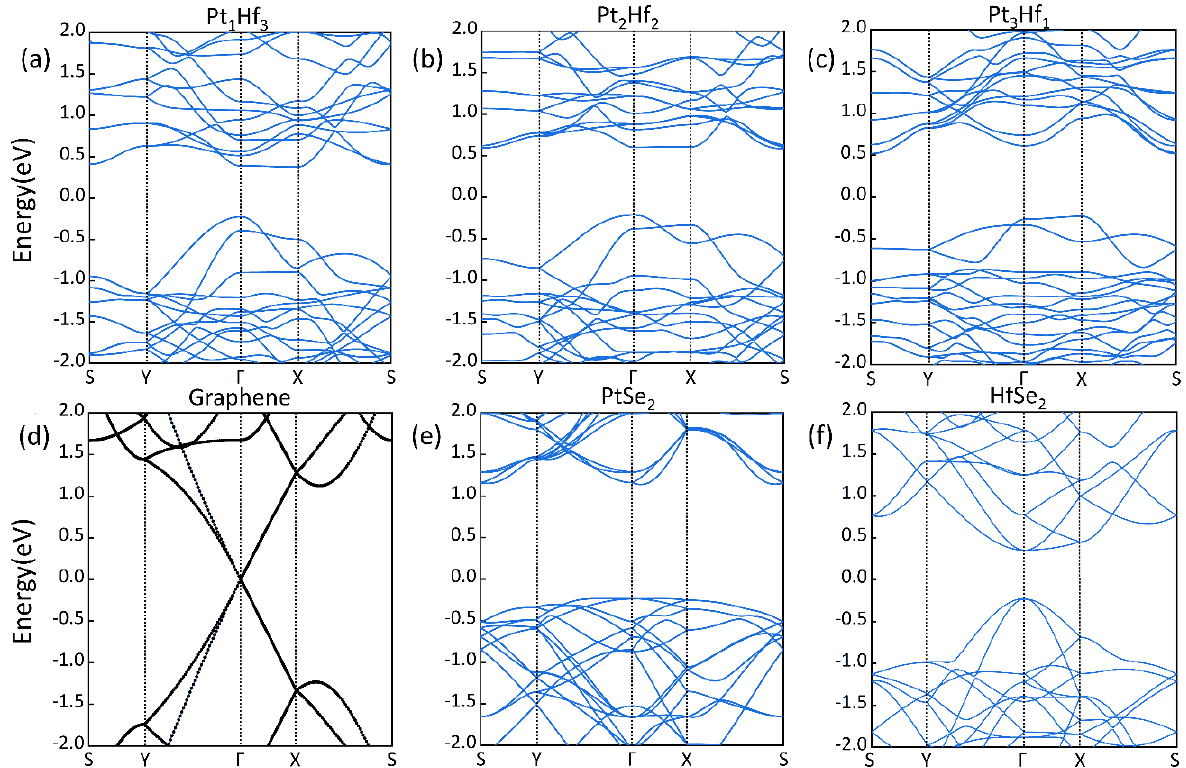
Figure 3. Band structures of monolayers: ( a ) Pt 1 Hf 3 , ( b ) Pt 2 Hf 2 , ( c ) Pt 3 Hf 1 , ( d ) Graphene, ( e ) PtSe 2 , and ( f ) HfSe 2 .